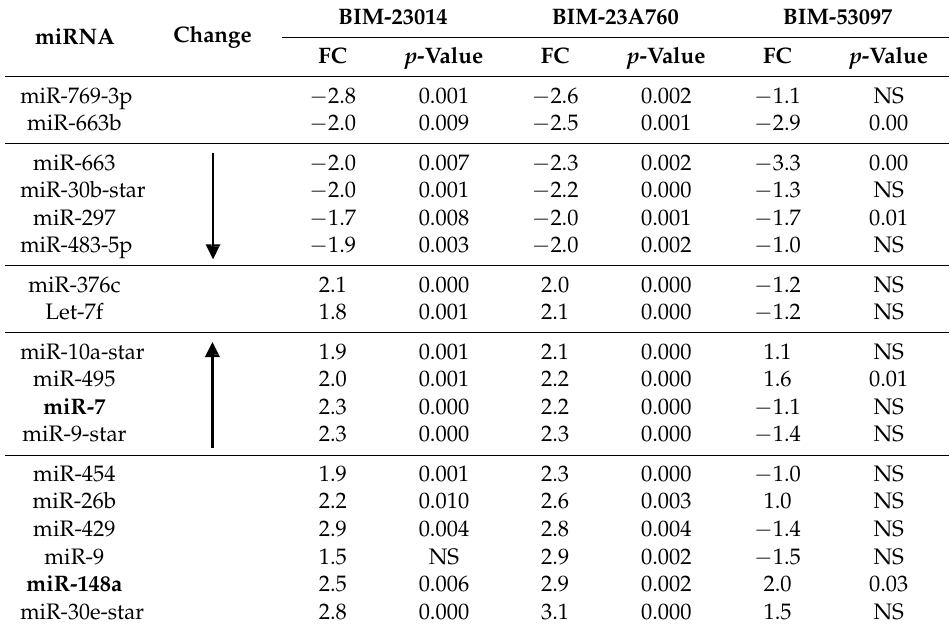
Table 4. Up- and down-regulated miRNAs based on Somatostatin analogue (SSA) treatment. miRNA Change